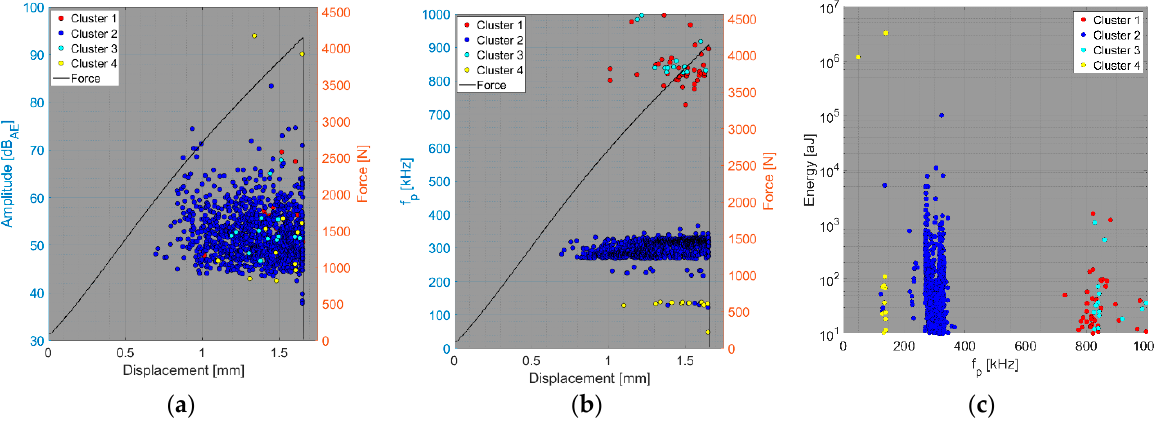
Figure 19. Clustering results for a CPCT representative sample using a spectral clustering algorithm (DWC 454 dataset).